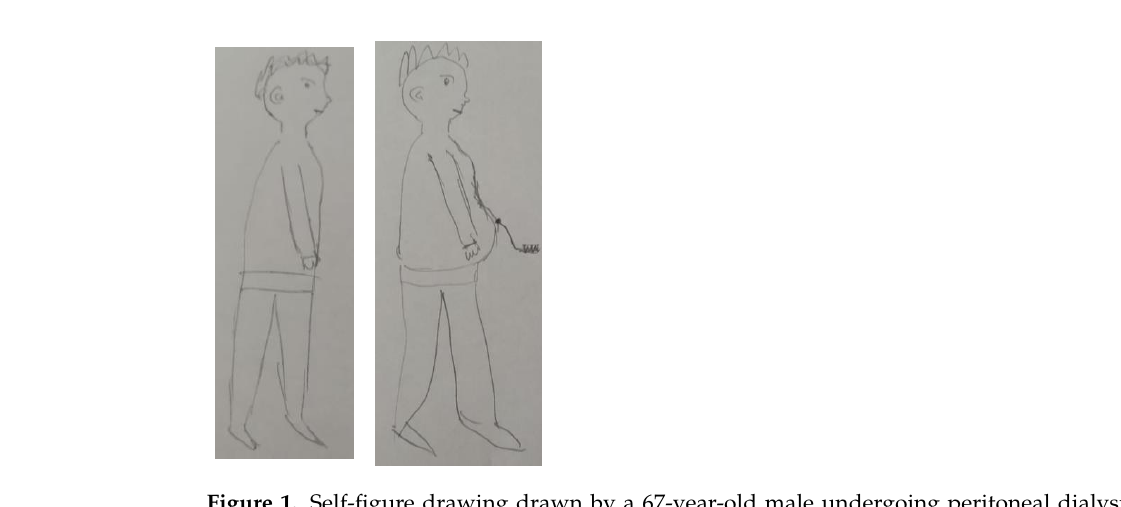
Table 3. Drawing indicators for drawing of the self before diagnosis, N = 29.